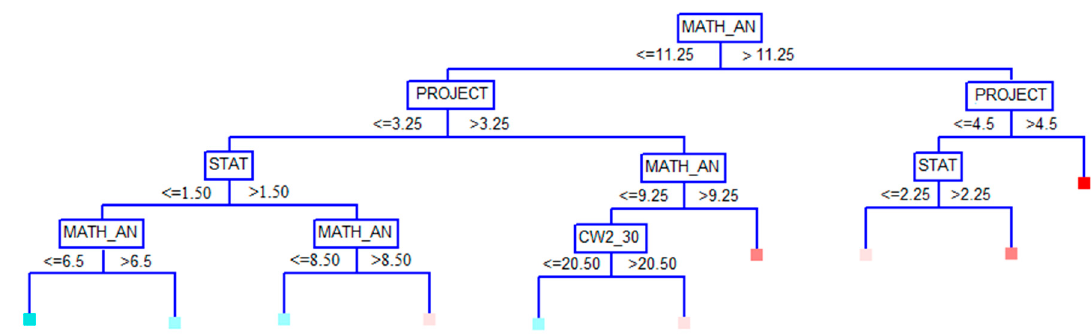
Figure 4. Diagram of the regression tree of CART model M 1 with split variables denoted and respective threshold values for each tree node.